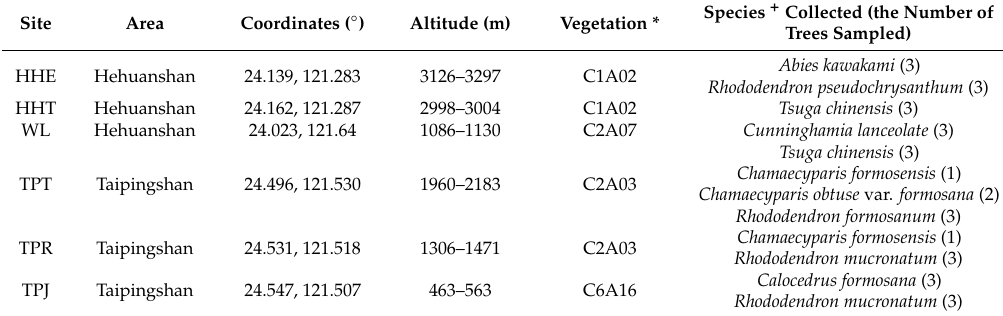
Figure 1. Map of sampling sites. There were six sampling sites at the Taipingshan and Hehuanshan areas in northeastern and central Taiwan. The major cities in Taiwan are indicated by black dots. Table 1. Sampling site information and tree species collected at each site.